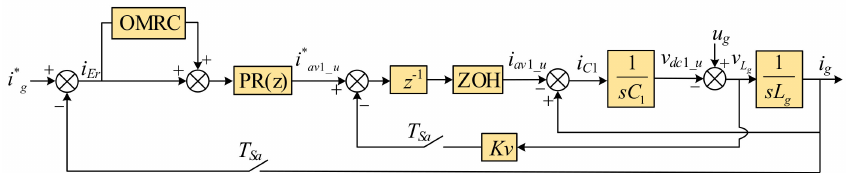
Figure 7. Block diagram of closed-loop control configuration in discrete domain.